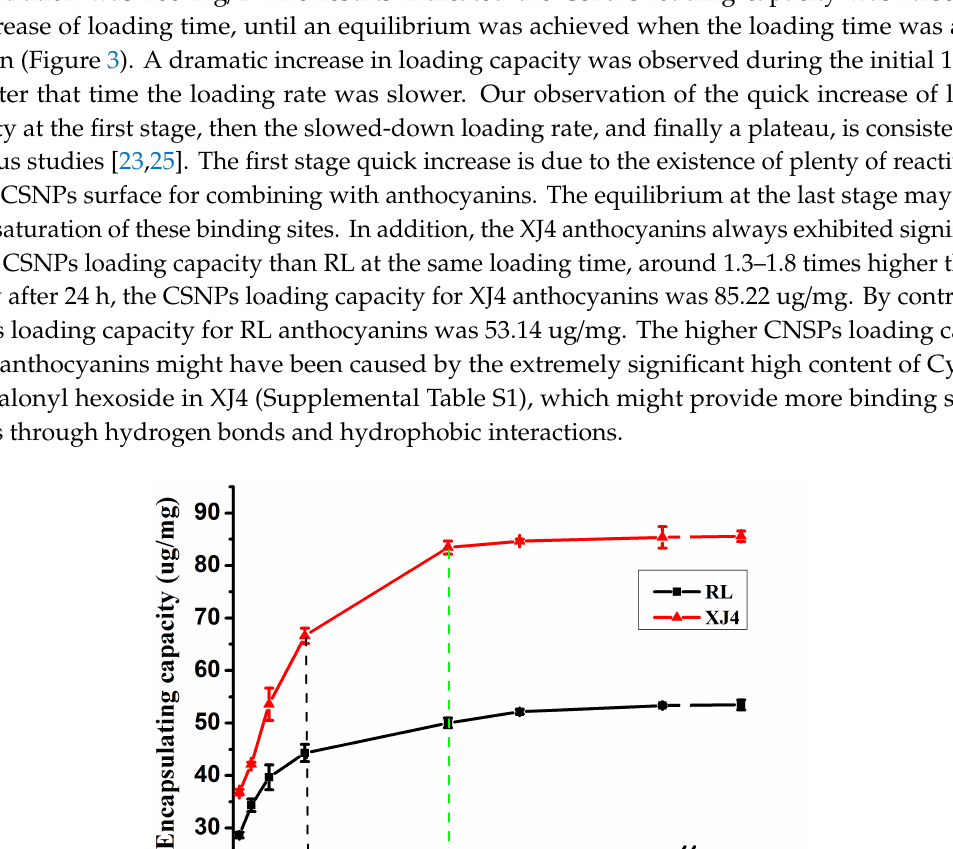
Figure 3. Encapsulating capacity of CSNPs under various encapsulating times of anthocyanins.